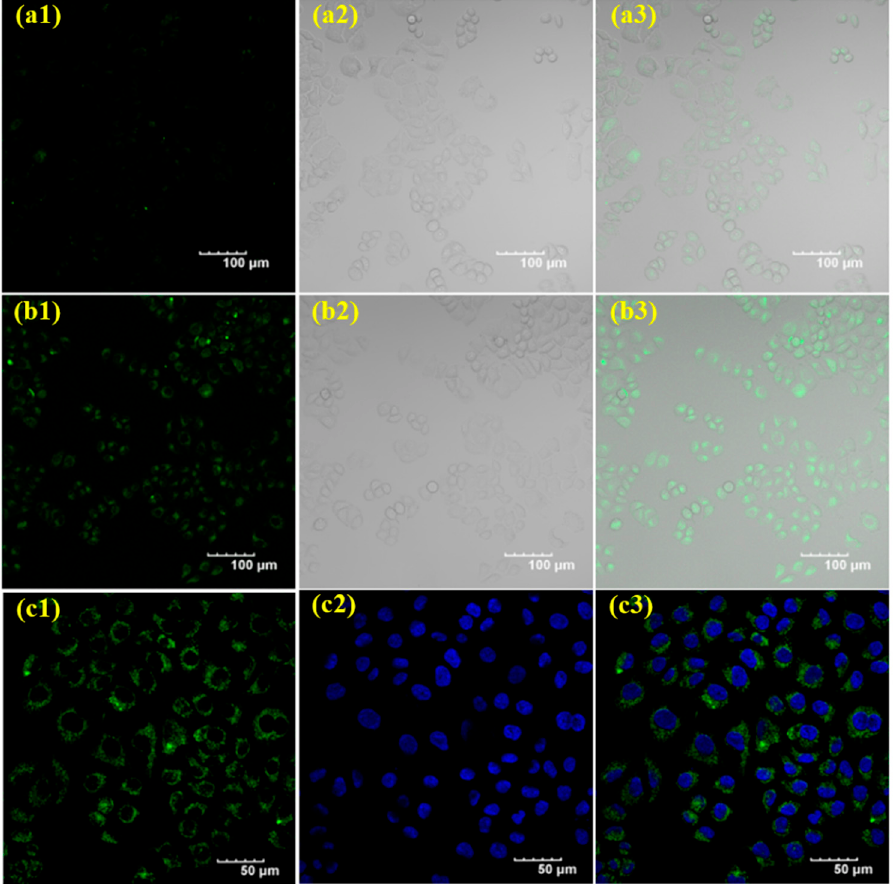
Figure 5. Confocal fluorescence images of HeLa cells. ( a ) HeLa cells with P (1.0 µM) for 30 min; ( b ) HeLa cells with P (1.0 µM) for 30 min and then with Hg 2+ (1.0 µM) for 30 min (( a1 – b1 ): dark field; ( a2 – b2 ): bright field; ( a3 – b3 ): ( a1 – b1 ) merged with ( a2 – b2 ), respectively); ( c ) HeLa cells with P (1.0 µM) for 30 min, then with Hg 2+ (1.0 µM) for 30 min and Hoechst 33342 (0.25 µg/mL) for 15 min ( c1 : green channel with P ; c2 : blue channel with Hoechst 33342; c3 : overlay of images showing fluorescence from P ( c1 ) and Hoechst 3342 ( c2 )).